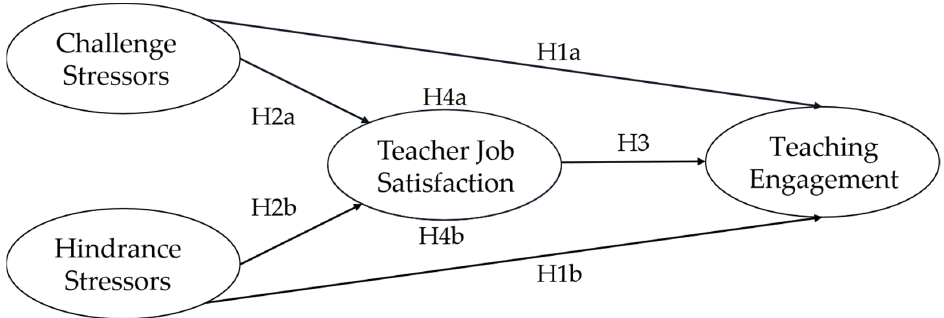
Figure 1. Conceptual model of the relationship among challenge—hindrance stressors, teacher job satisfaction, and teaching engagement.